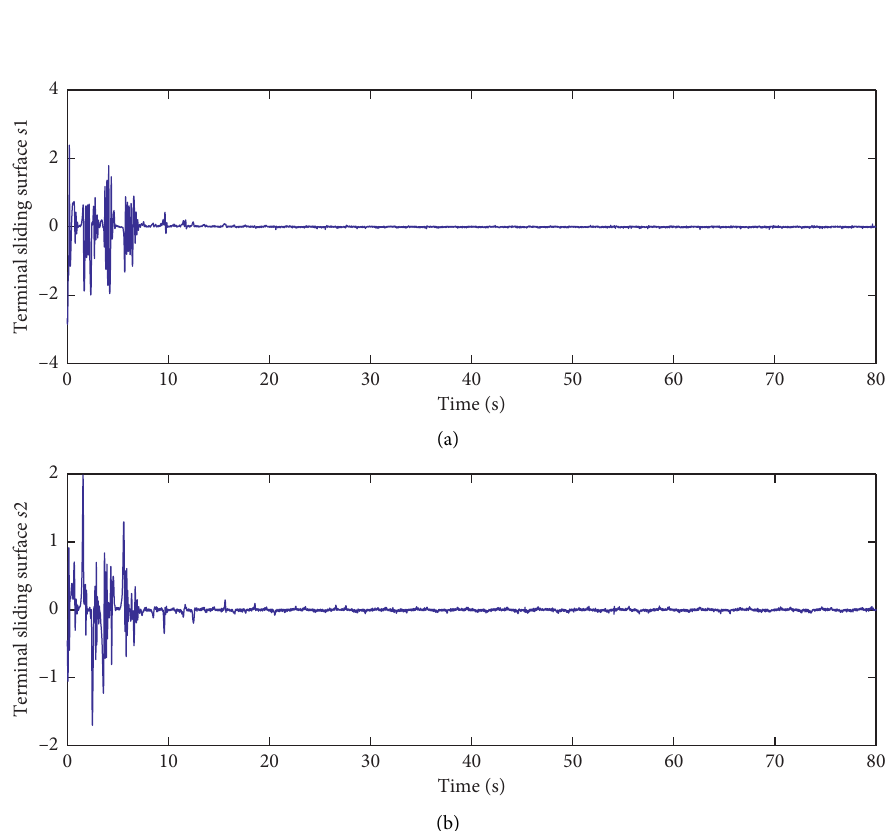
Figure 8: Conventional fast TSM